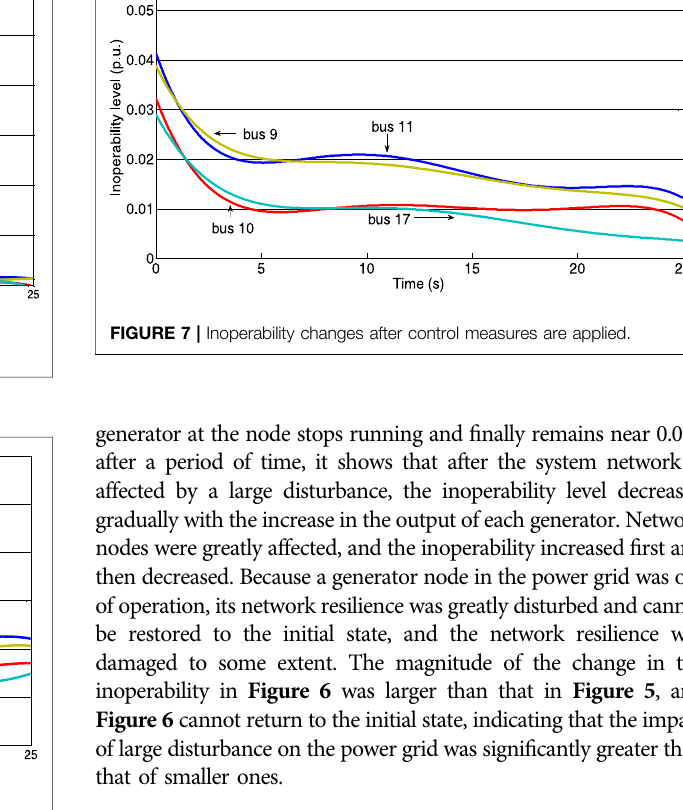
FIGURE 6 | Change of node inoperability under large disturbances.